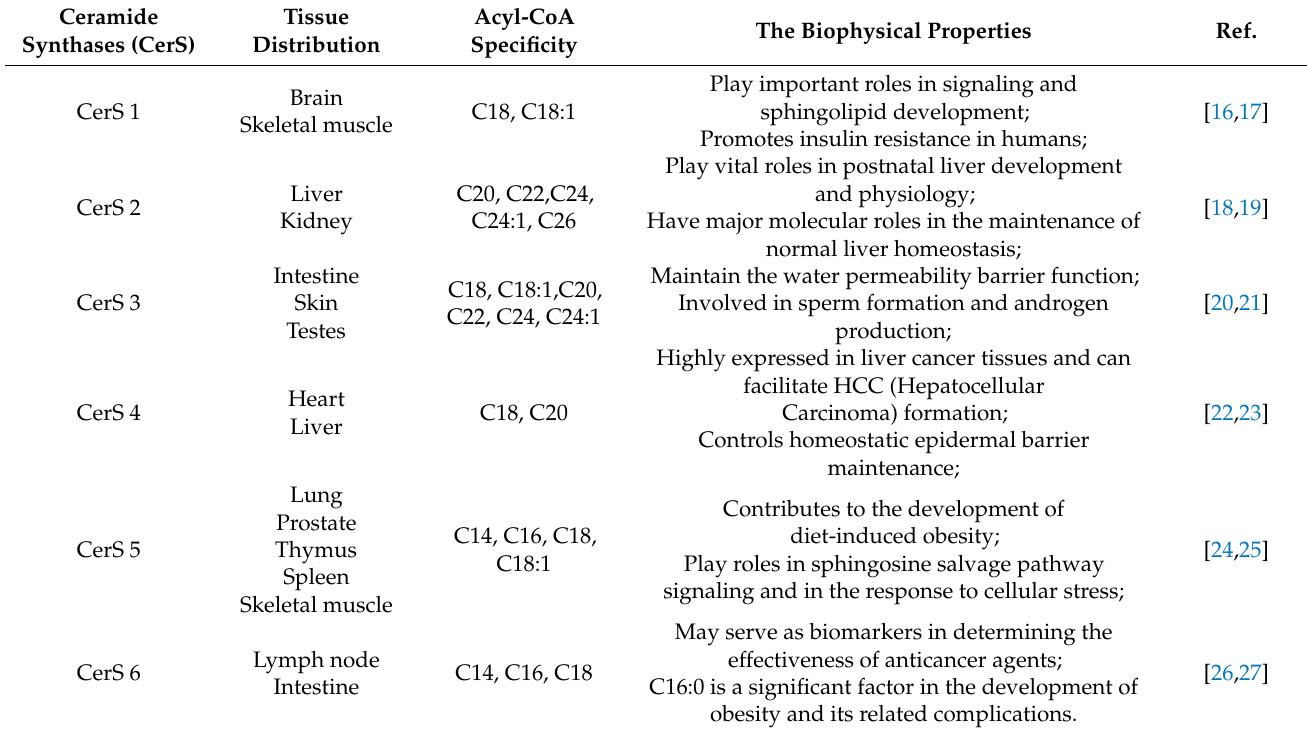
Table 1. The synthesis of ceramides is regulated by six ceramide synthases (CerS1–CerS6), and their expression profiles differ throughout the body. The CerS are differentially distributed in various tissues, presumably to meet the different physiological needs of each tissue; Acyl-CoA Specificity (Acetyl-Coenzyme A Specificity).